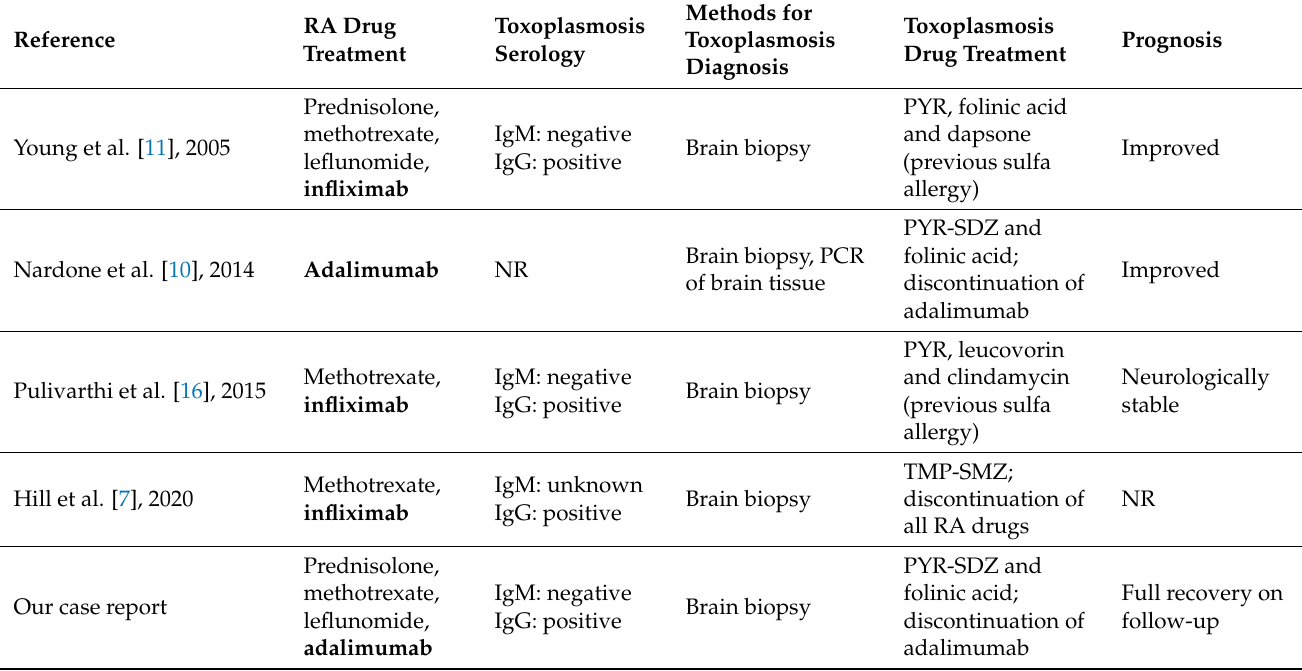
Table 1. Summary of reported cases of cerebral toxoplasmosis in patients with RA treated with biologic